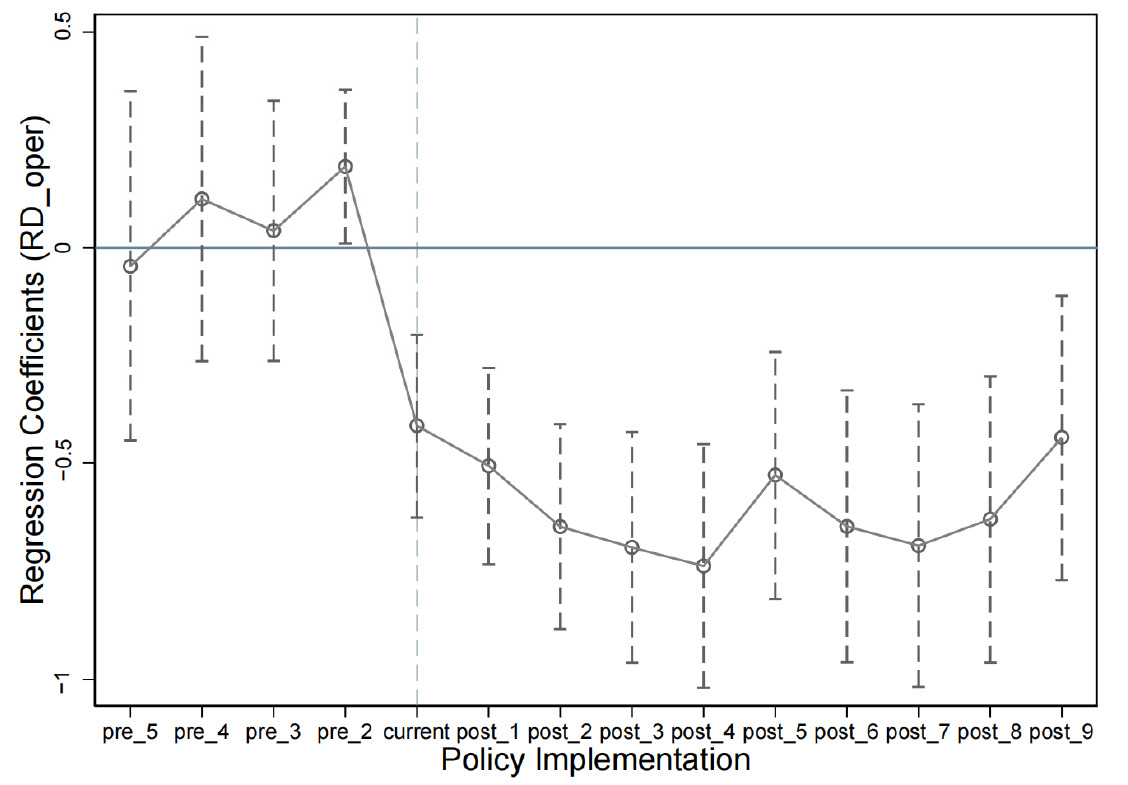
Figure 4. Parallel trend tests for replacing explanatory variables with policy dynamic effects.